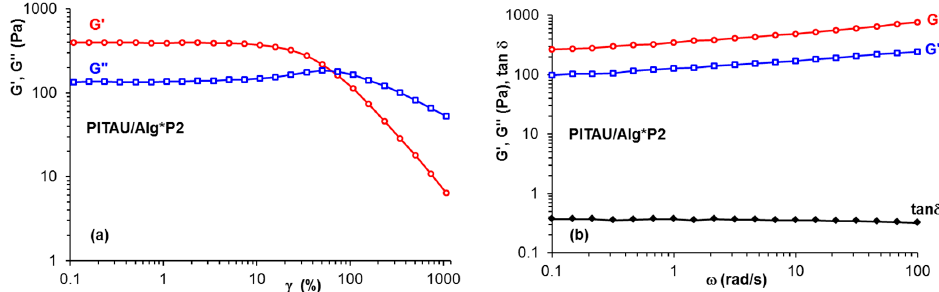
Figure 3. The dependence of the viscoelastic parameters for the sample PITAU/Alg*P2 in ( a ) ampli- tude sweep tests and ( b ) frequency sweep tests.